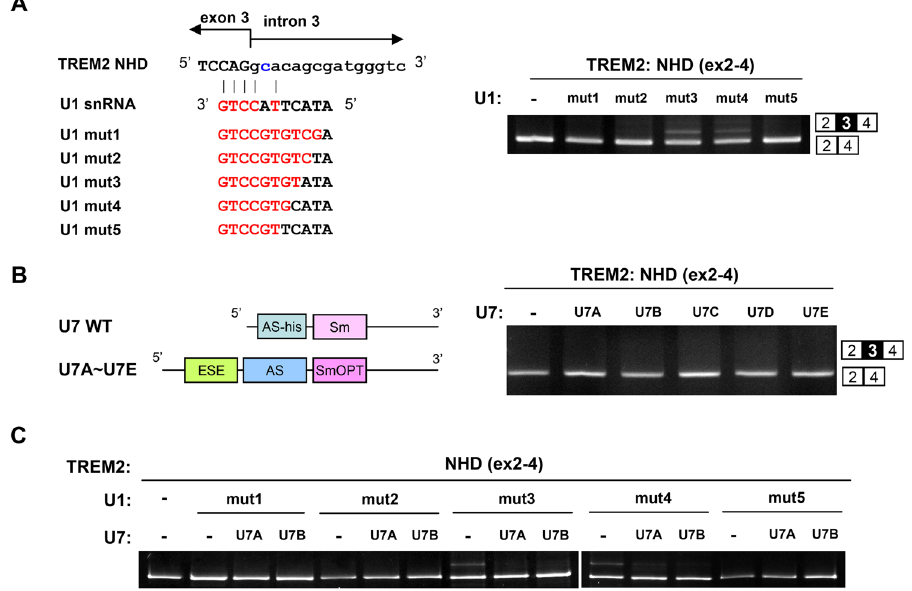
Figure 2. Correction of exon 3 skipping by modified U1 and U7 snRNAs. ( A ) The left panel shows the sequence of the 5 ′ region of the unmodified (WT) and modified U1 snRNAs used in this study. The mutated nucleotide in the NHD minigene is shown in blue. Nucleotides of the U1 snRNA constructs complementary to the 5 ′ splice site region of TREM2 intron 3 are indicated in red. The right panel shows the results of a splicing assay using modified U1 snRNA. The NHD minigene was transfected with either an empty vector or modified constructs. Splicing patterns were detected by RT-PCR and agarose gel electrophoresis. U1mut3 increased exon 3 inclusion. ( B ) The left panel shows a schematic diagram of the modified U7 snRNA used in this study. U7A–U7E were designed to hybridize to different regions in exon 3 of TREM2 . Refer to the text for the details regarding SmOPT and ESE (exonic splicing enhancer). The right panel shows the results of a splicing assay using the modified U7 snRNA. The NHD minigene was transfected with either an empty vector or modified constructs. Splicing patterns were detected as in ( A ). U7A and U7B did not increase exon 3 inclusion when used separately or simultaneously. ( C ) Co-expression of U1 and U7 constructs to modulate exon 3 splicing. Cells were transfected with the NHD minigene together with the U1 and U7 constructs as indicated. Splicing patterns were detected as in ( A ). Original gel images are shown in Supplementary Fig.